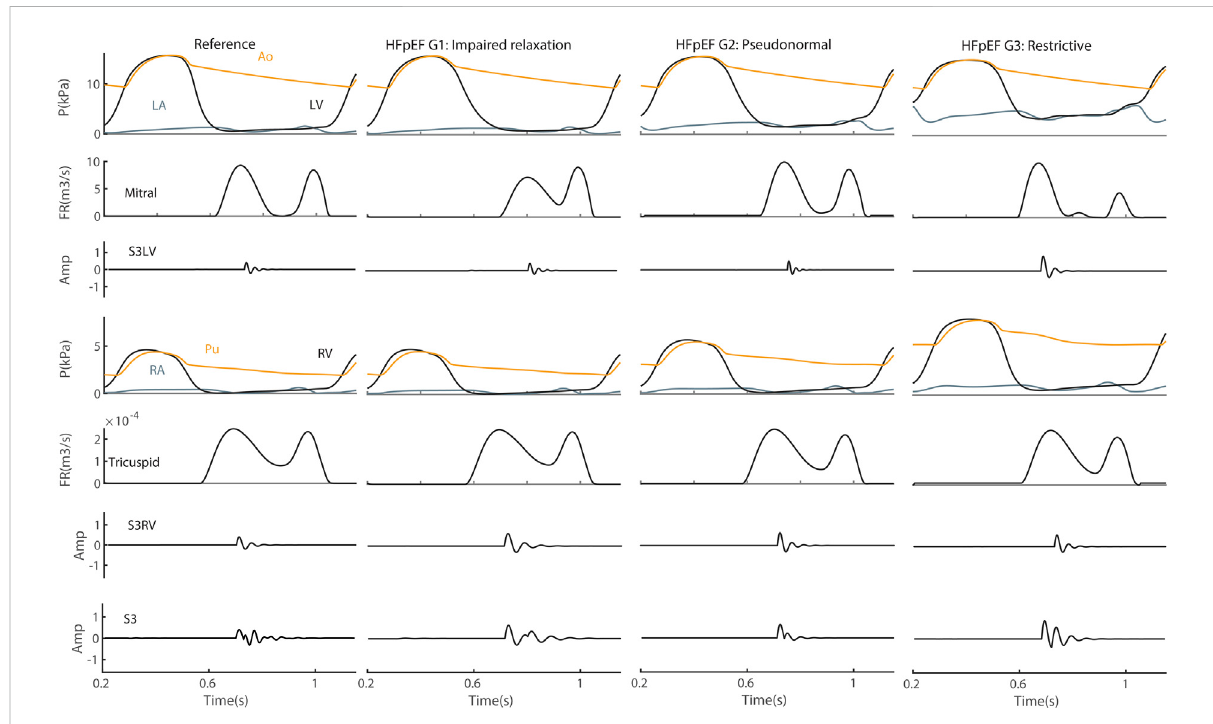
FIGURE 9 S3inheartfailurewithpreservedejectionfraction(HFpEF).Amp,amplitude;Ao,aorta;FR, fl owrate;G1,grade1;G2,grade2;G3,grade3;LA,left atrium; LV, left ventricle; P, pressure; Pu, pulmonary artery; RA, right atrium; RV, right ventricle; S3LV, left ventricular S3; S3RV, right ventricular